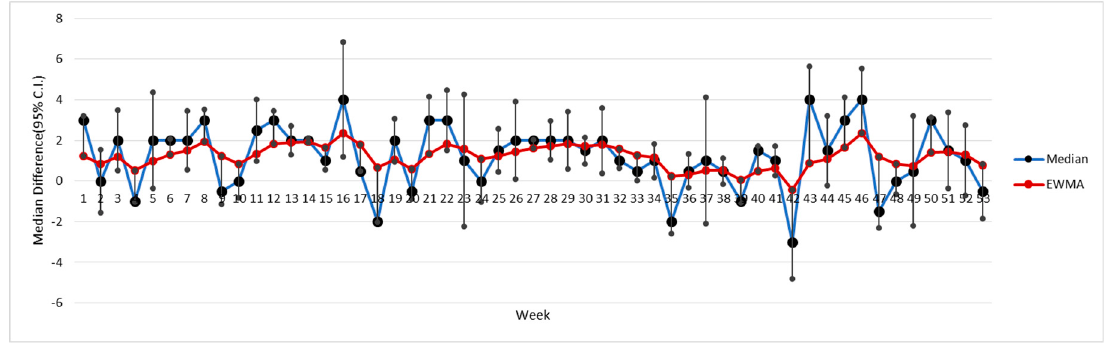
Figure 4. LOS difference of median and 95% CI between correct and incorrect D x ’s of aneurysm on admission.